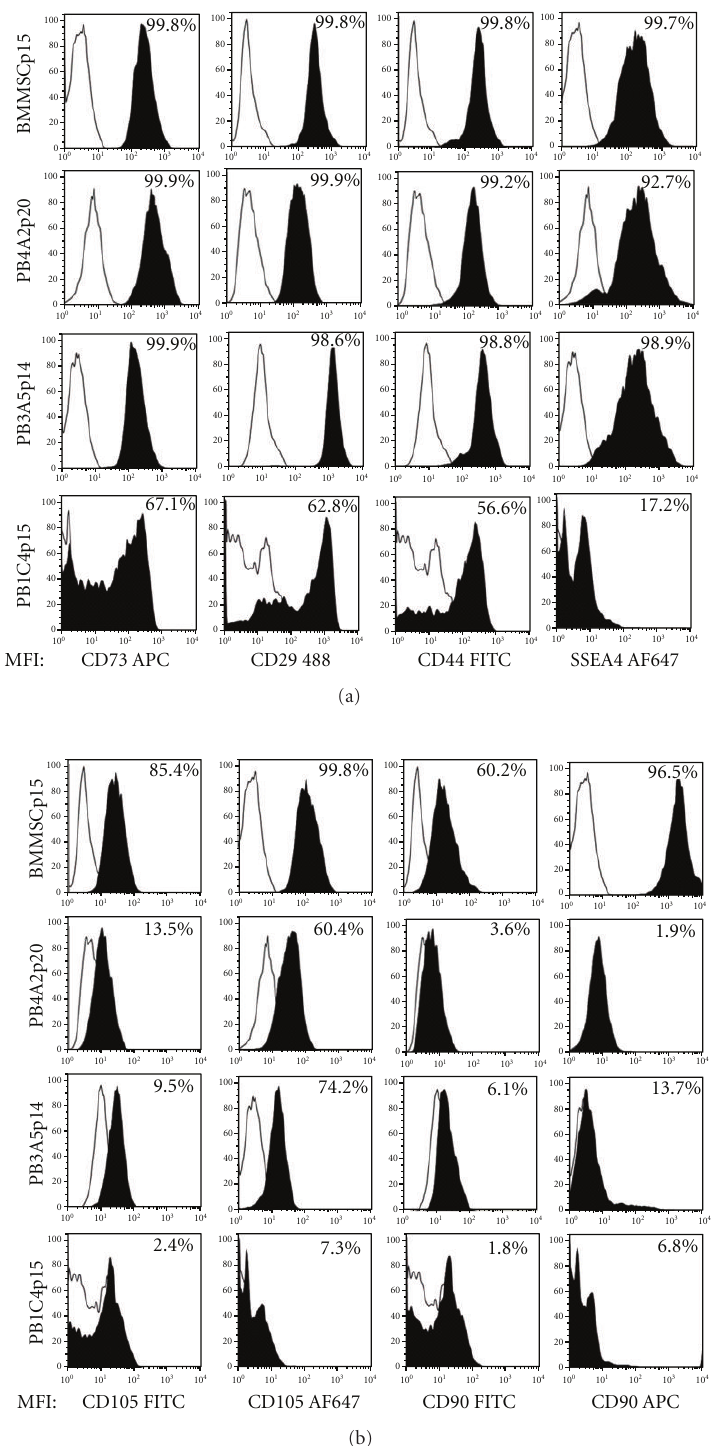
Figure 2: Flow cytometry of cell surface markers. Cell populations BMMSCp5, PB4A2p20, PB3B5p14, and PB1C4p15 were stained with antibodies against (a) CD73, CD29, CD44, SSEA4 and (b) against CD90 and CD105. Cell populations are indicated in vertical text on the left of the corresponding row of histograms for each marker. The markers and conjugated fluarochromes are indicated at the bottom of the corresponding column of each histogram. The x -axis of all histograms corresponds to the mean florescence intensity (MFI) in log scale. The y -axis is the percentage (%) of events in linear scale that were detected at each position of MFI along the x -axis. Cell populations were gated to exclude presumptive dead cells and debris. The histogram of isotype controls is depicted by black line and the marker that is assayed is depicted in the filled histogram. 10,000 events were scored for all populations. The percentage of immunostained cells, excluding those stained by isotype controls, is indicated within each